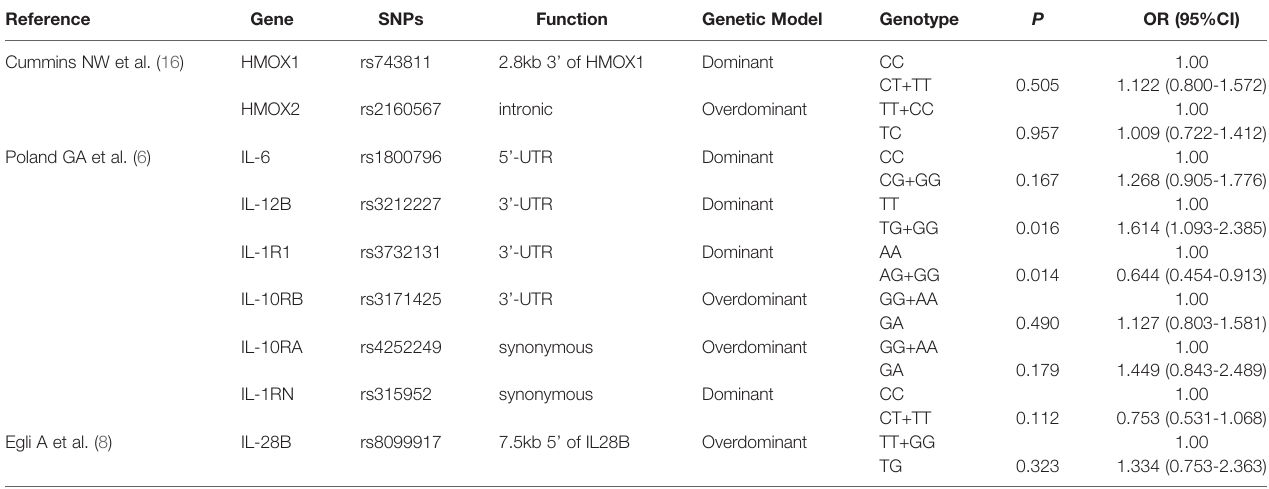
TABLE 4 | Multivariate logistic regression analysis of 9 SNPs from published studies.